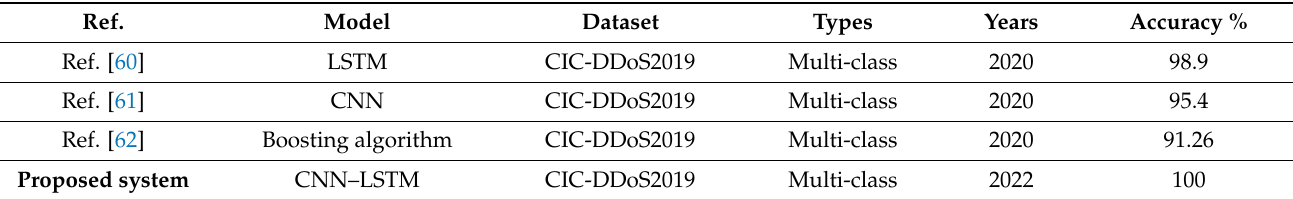
Table 6. Comparison results between CNN–LSTM model against existing security systems for detecting attacks on Agriculture 4.0.